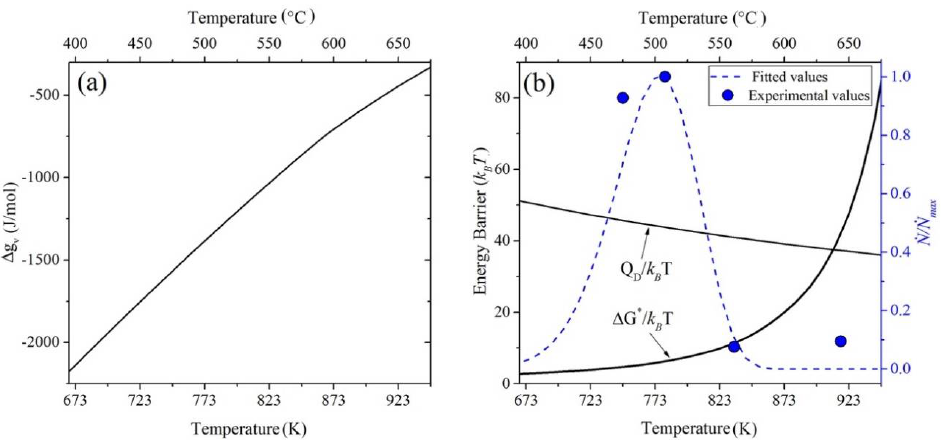
Figure 14. ( a ) Nucleation driving force and ( b ) fitted energy barrier and nucleation rate according to classical nucleation theory.